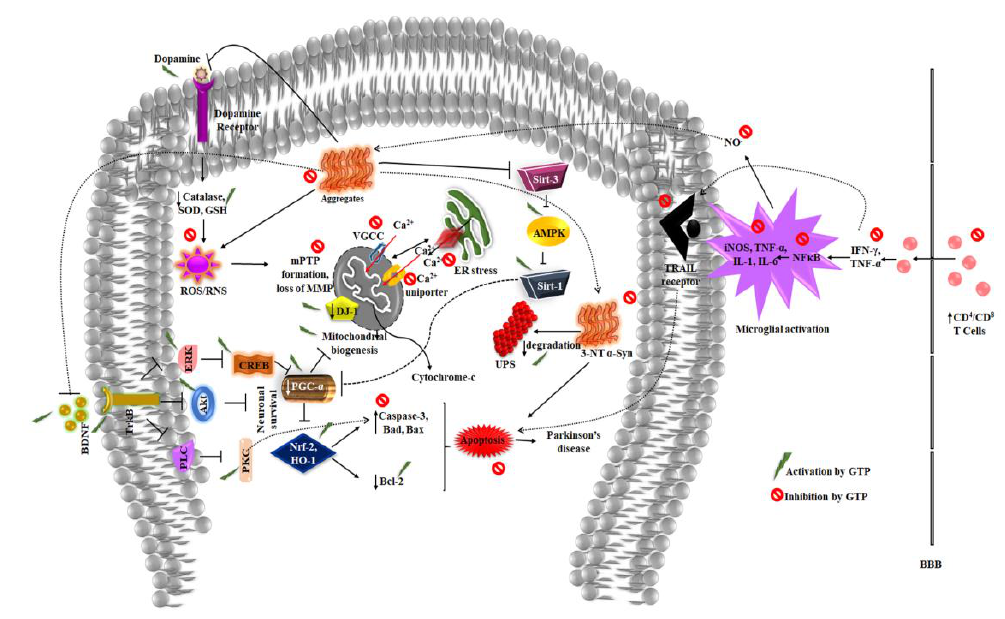
Figure 3. GTP’s role in inducing mitochondrial biogenesis, activating stress response genes and gated calcium channel; UPS—Ubiquitin proteosome suppressing neuroinflammation, inhibiting oxidative stress, and apoptosis of dopaminergic neurons and protecting from the pathological changes occurring during Parkinson’s disease (VGCC—Voltage gated calcium channel; UPS—Ubiquitin proteosome system).